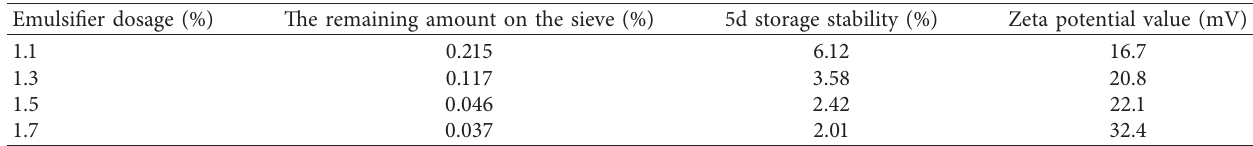
Table 2: Effect of cationic emulsifier dosage on emulsion performance.